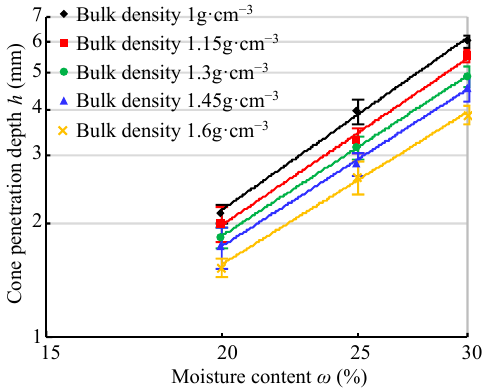
Figure 5. Relation curves of cone penetration depth and moisture content. Table 4. Plastic limit, liquid limit, plasticity index, and fitting curve for different paddy soils. Factors and Levels